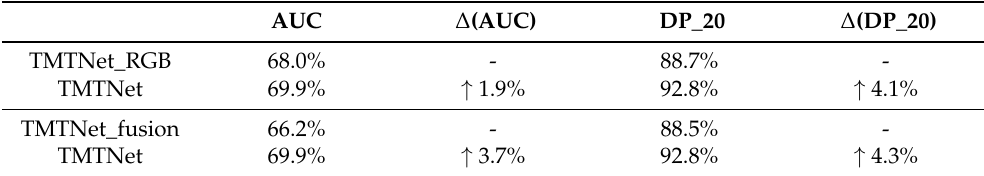
Table 4. The AUC score and DP_20 value of the TMTNet tracker, TMTNet_RGB tracker, and TMT- Net_fusion tracker.